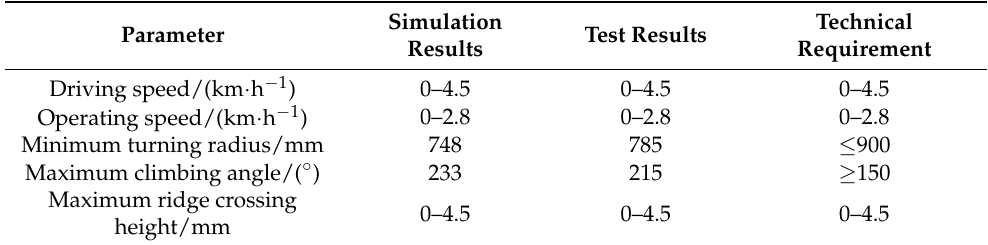
Table 5. Field test results.